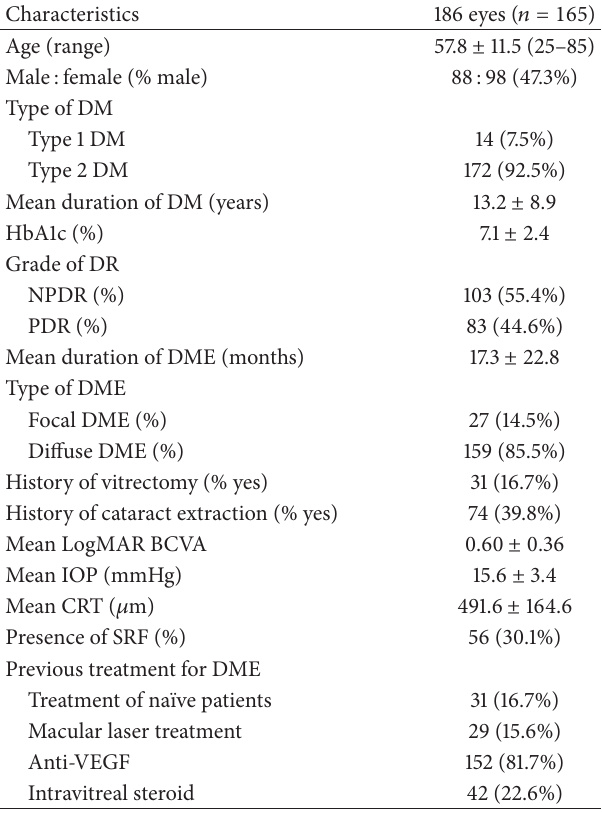
Table 1: Patient demographics and clinical characteristics of the study eyes.